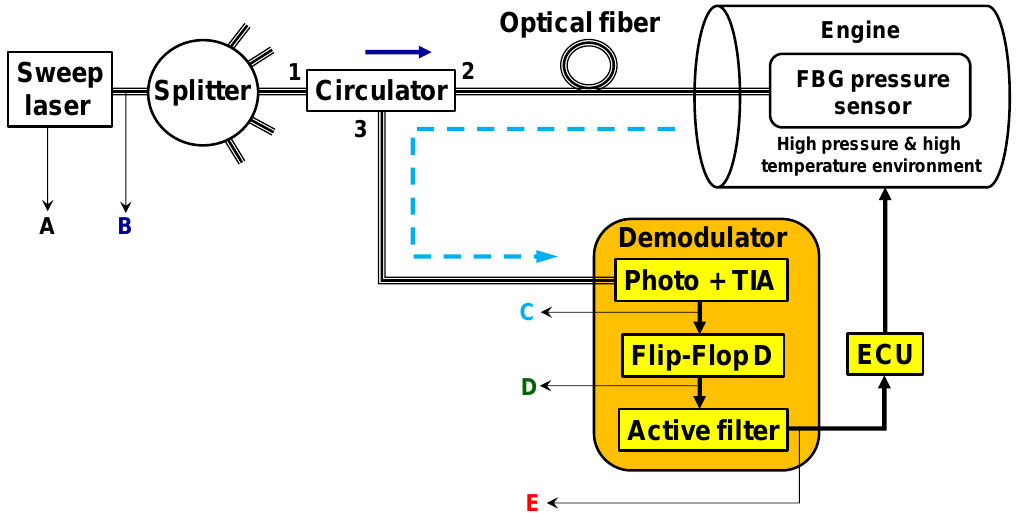
Figure 1. The proposed FBG-PWM demodulator. The letters from A to E represent points with signals waveforms from the sweep laser to the demodulator output.